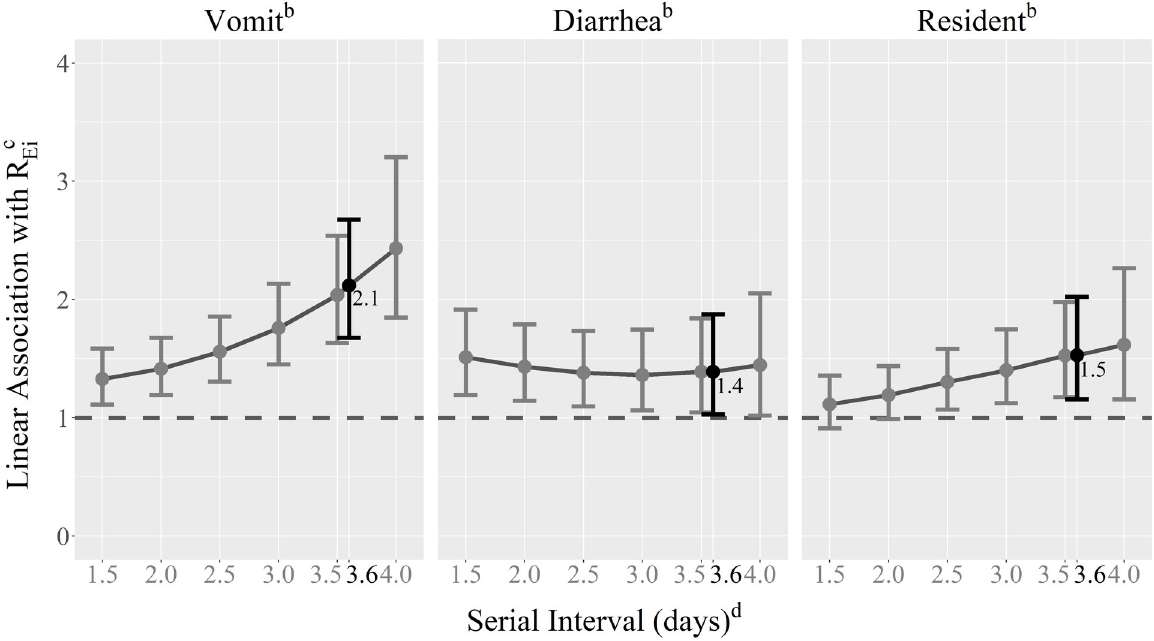
Fig 3. Associations between individual reproduction numbers, R , and symptoms/characteristics of norovirus cases by serial interval Ei length a . a The serial interval length used in the final regression analysis is shown in black. b Associations were estimated using a mixed linear ), inverse-variance weighting, a random slope for outbreak number, and the regression model with a log-transformed outcome variable ( R Ei following dichotomous predictor variables: vomiting (vs. no vomiting), diarrhea (vs. no diarrhea), and resident (vs. staff). c Estimates from the model were exponentiated. d Estimates using a serial interval of 1.0 with a standard deviation of 2.0 (or 1.0) were unstable and therefore not